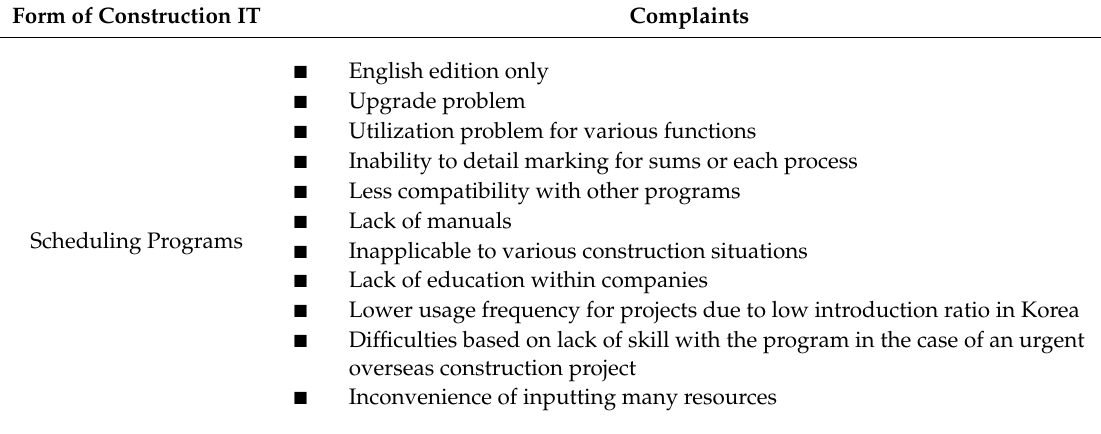
Table 3. Subject Matter of the